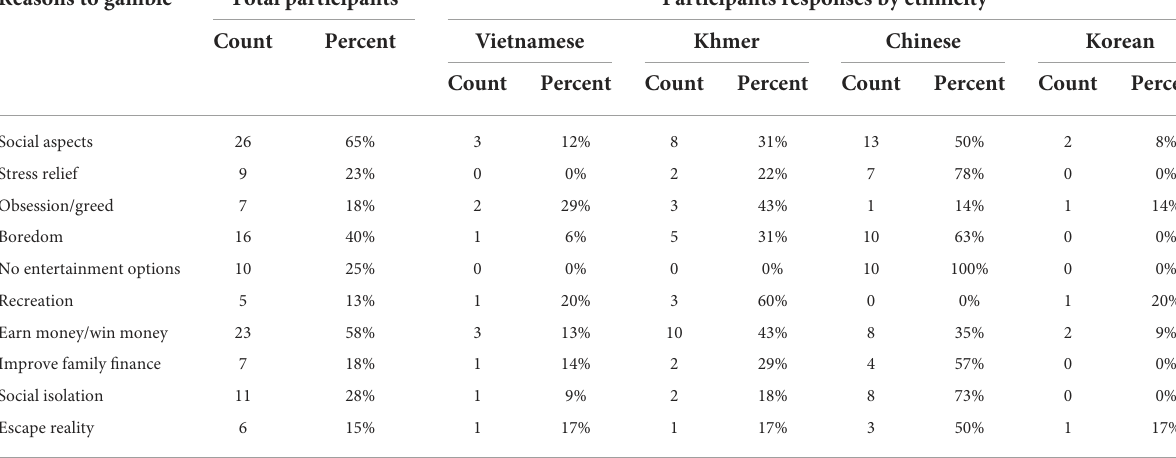
TABLE 2 Participants identified reasons why they thought Asians